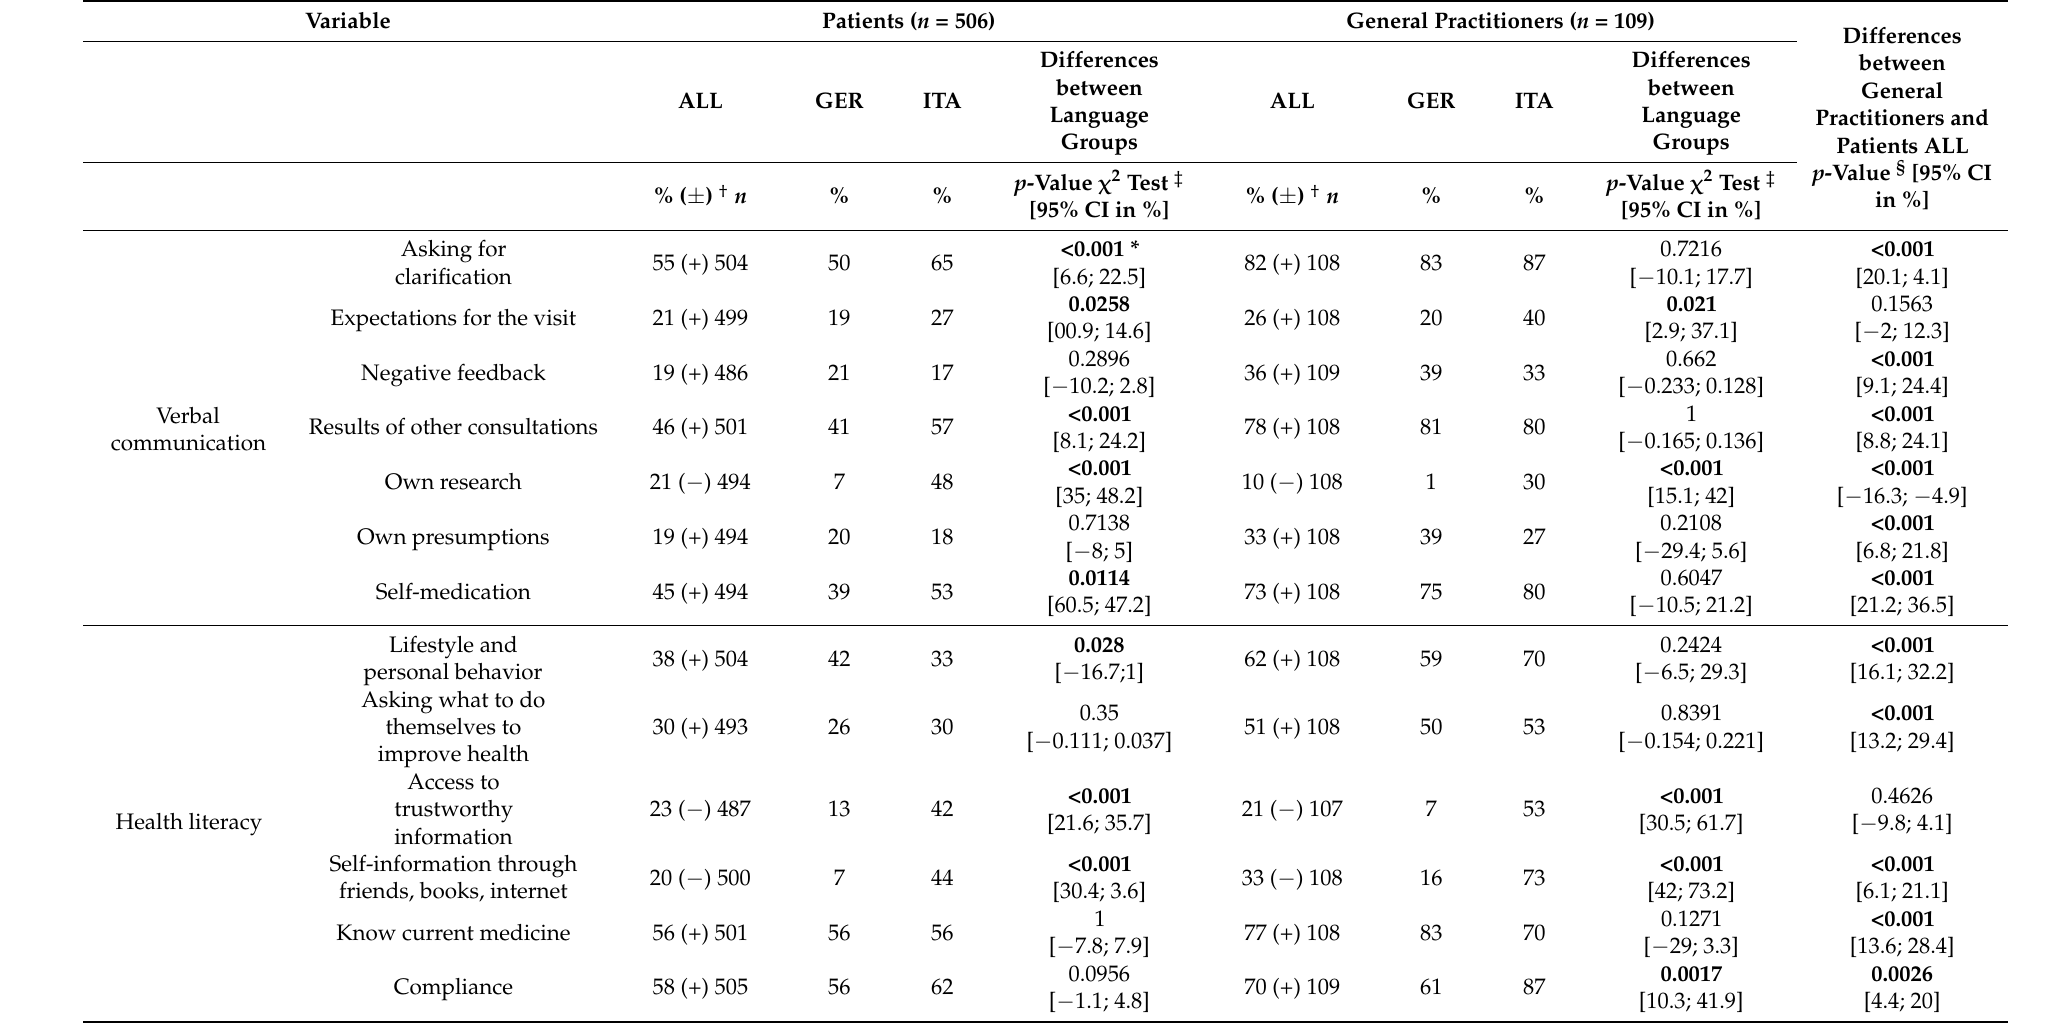
Table 2. Comparison between patients and general practitioners, and their respective language groups cited. Variable Patients ( n = 506) General Practitioners ( n = 109)